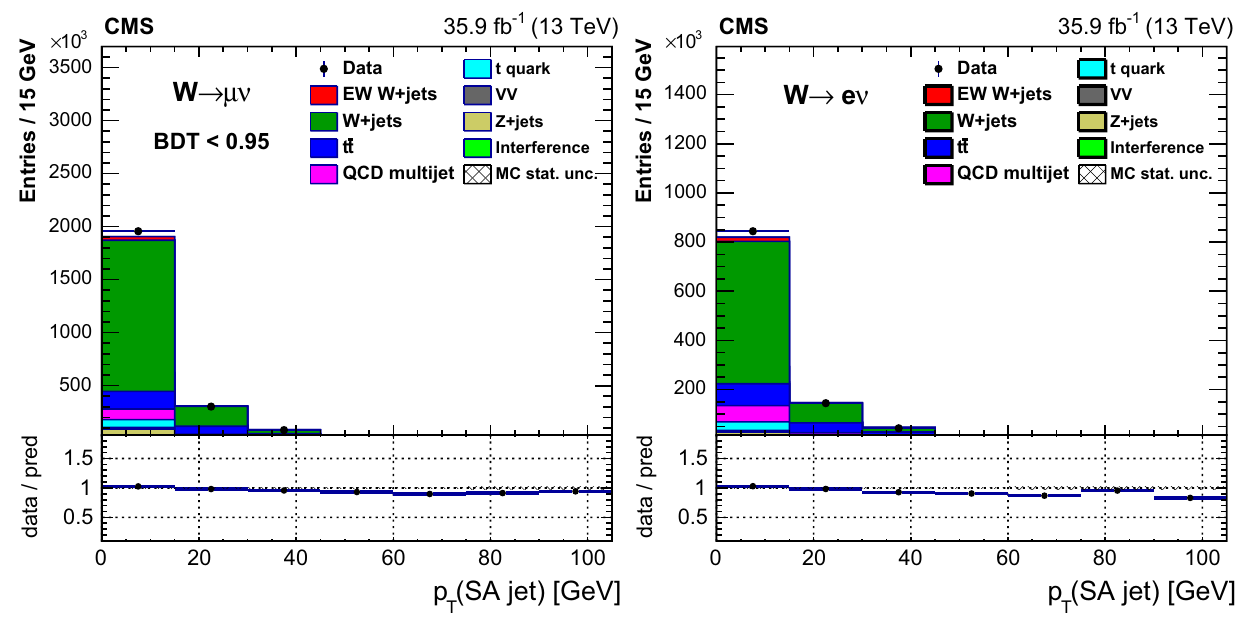
Fig. 25 Leading additional soft-activity (SA) jet p T for BDT < 0 . 95 in the muon (left) and electron (right)